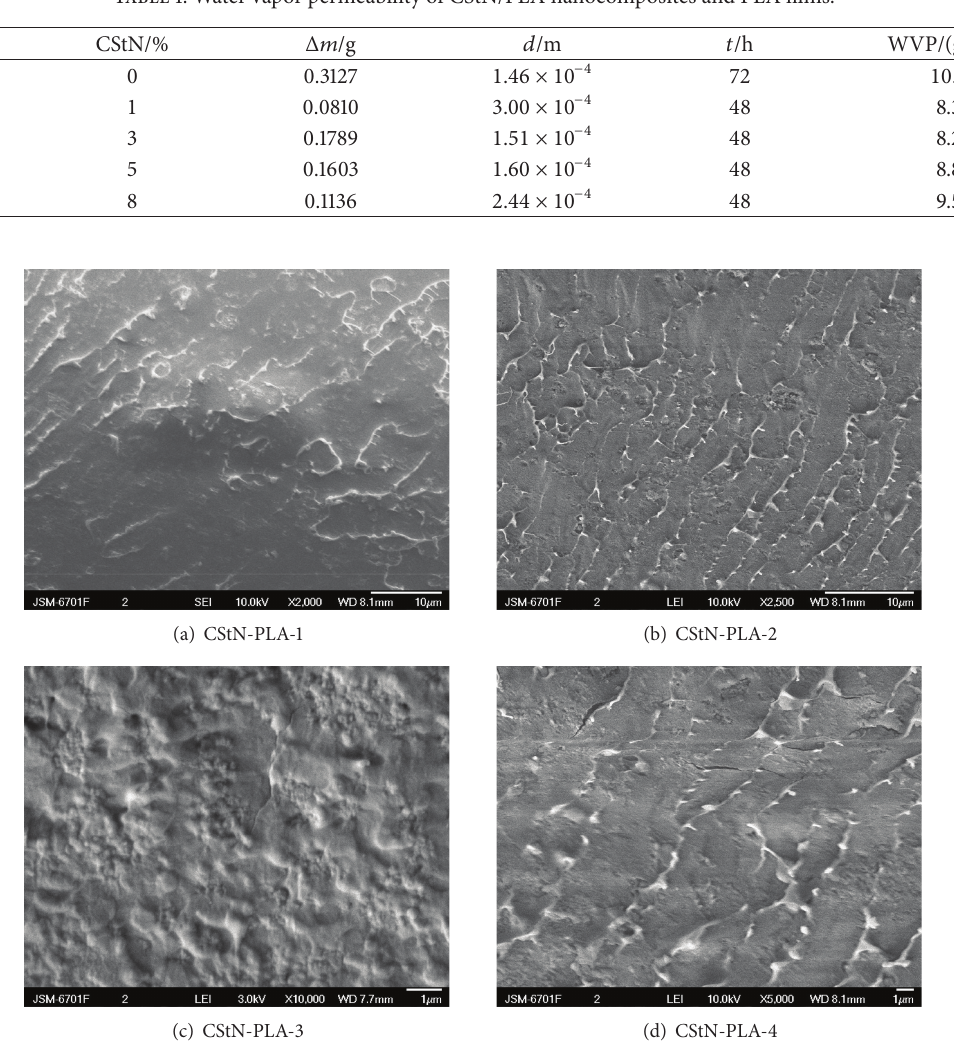
Figure 3: Morphologies of fractured surfaces of CStN/PLA nanocomposites after the tensile tests.